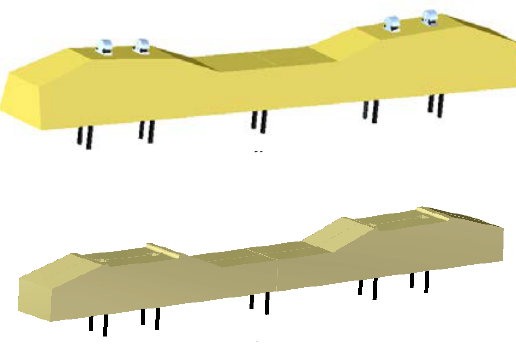
Fig. 3. The construction of anchor crossties: a – anchor crosstie SB-3; b – anchor crosstie